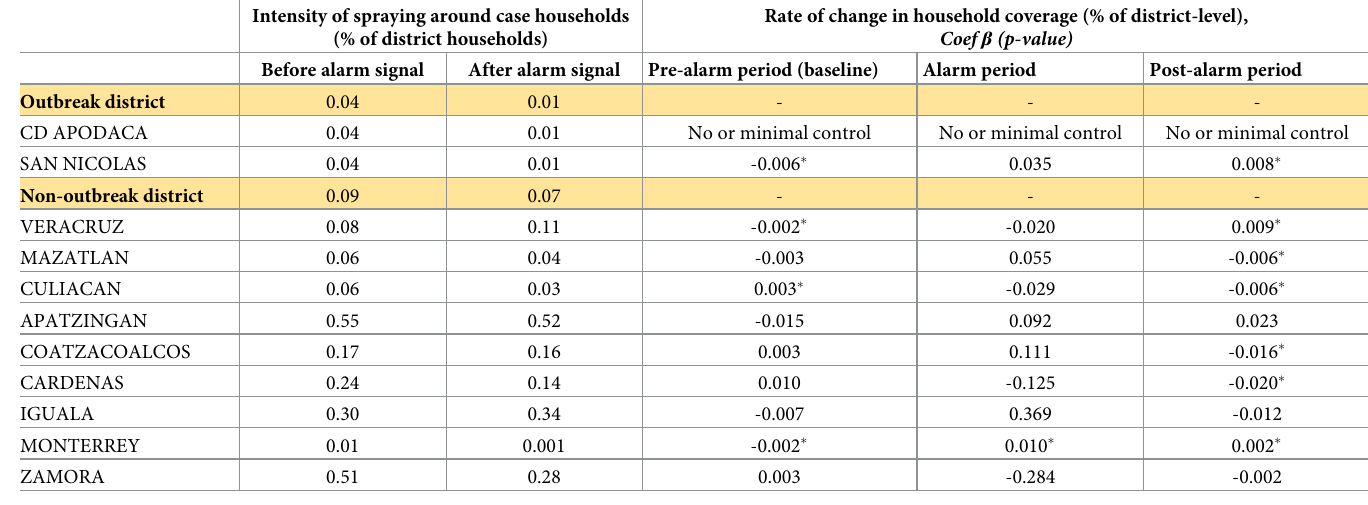
Table 5. Intensity of indoor spraying around case households (perifocal spraying). Percent of households treated before and after alarm signals and rate of change between periods in 2 outbreak and 9 non-outbreak districts with alarm signals. Intensity of spraying around case households (% of district